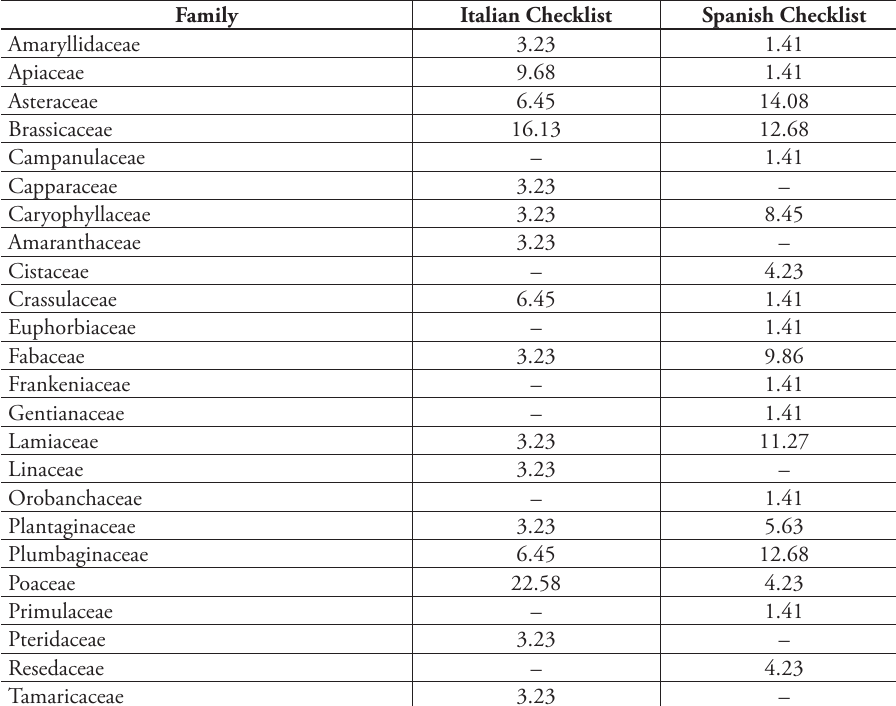
Table 3. Percentage of gypsophile taxa grouping by taxonomic families and a comparison between Italian and Spanish Checklists (Mota et al. 2011). Family Italian Checklist Spanish